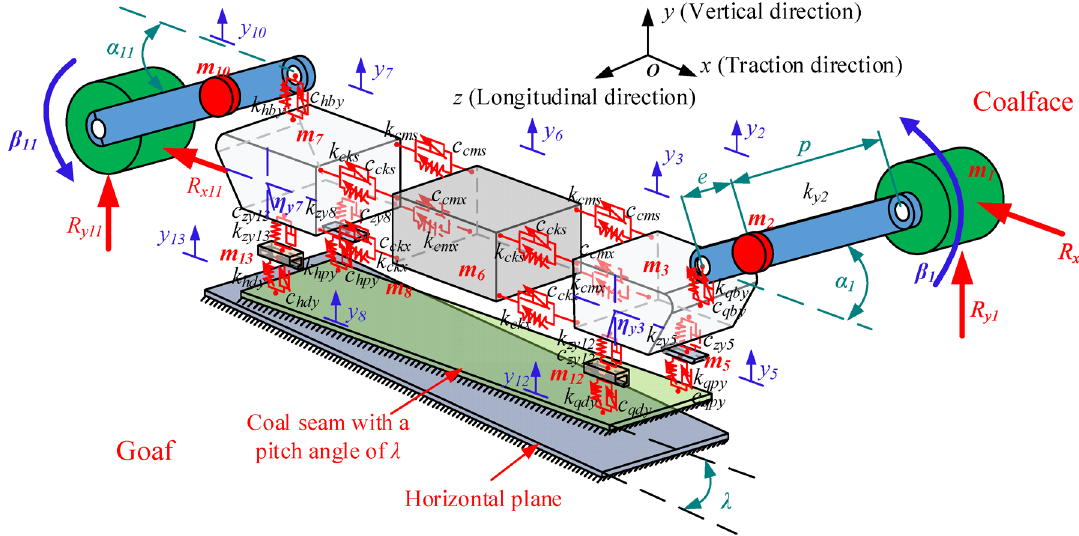
Figure 1. Vertical–pitch coupling nonlinear dynamics model of